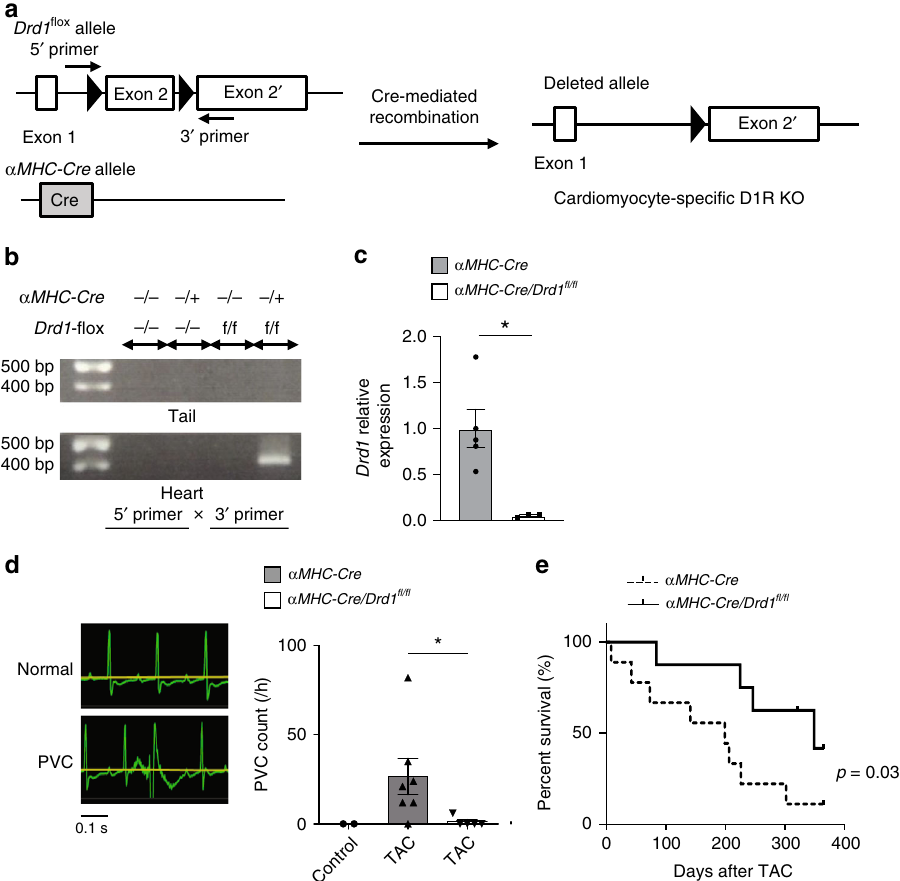
Fig. 2 Deletion of cardiac D1R ameliorates heart failure-associated ventricular arrhythmia. a Generation of cardiac-speci fi c D1R-de fi cient mice and the design of the PCR primer. KO knockout. b Representative results of the genotyping PCR from both tail and heart tissues. Genomic DNA was extracted from the mice with indicated genotypes. c Bar graph showing the expression of Drd1 in TAC-operated hearts of α MHC-Cre or α MHC-Cre/Drd1 fl / fl mice assessed by qPCR; (TAC-operated α MHC-Cre , n = 5; and TAC-operated α MHC-Cre/Drd1 fl / fl , n = 3). Data are shown as mean and s.e.m. Statistical signi fi cance was determined by Mann – Whitney U test; * p = 0.036 versus control. d Left: representative surface electrocardiogram recordings of the normal sinus rhythm (normal) and the premature ventricular contraction (PVC). Right: bar graph showing the frequency of drug-induced PVC in α MHC-Cre and α MHC-Cre/ Drd1 fl / fl mice under anesthesia. The frequency of PVC in α MHC-Cre mice before TAC operation is shown as a control; (control, n = 2; α MHC-Cre (TAC), n = 7; and α MHC-Cre/Drd1 fl / fl (TAC), n = 5). Data are shown as mean and s.e.m. Statistical signi fi cance was determined by Kruskal – Wallis test followed by Dunn ’ s multiple comparisons test; * p = 0.023; α MHC-Cre (TAC) versus α MHC-Cre/Drd1 fl / fl (TAC). e Survival curves comparing post-TAC survival of α MHC-Cre and α MHC-Cre/Drd1 fl / fl mice ( α MHC-Cre , n = 8; and α MHC-Cre/Drd1 fl / fl , n = 9). Statistical analysis was performed by Gehan – Breslow – Wilcoxon test; * p =